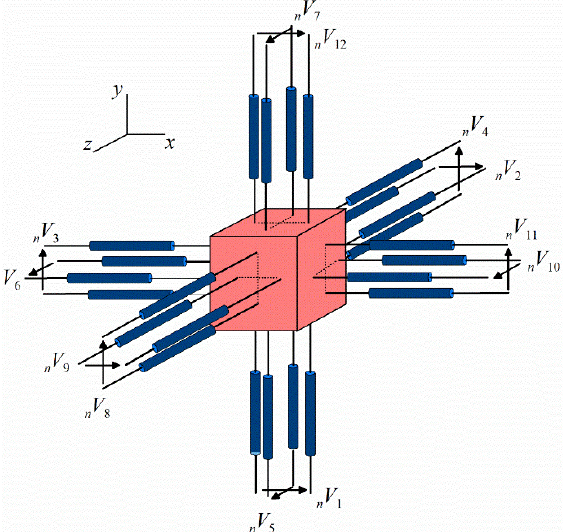
Figure 1. The 3D Symmetrical Condensed Node (3DSCN). Basic structure only containing the link lines. Extra stubs must be also added to independently adjust electromagnetic properties. The red box at the center denotes formal connections that describe Maxwell’s equations.